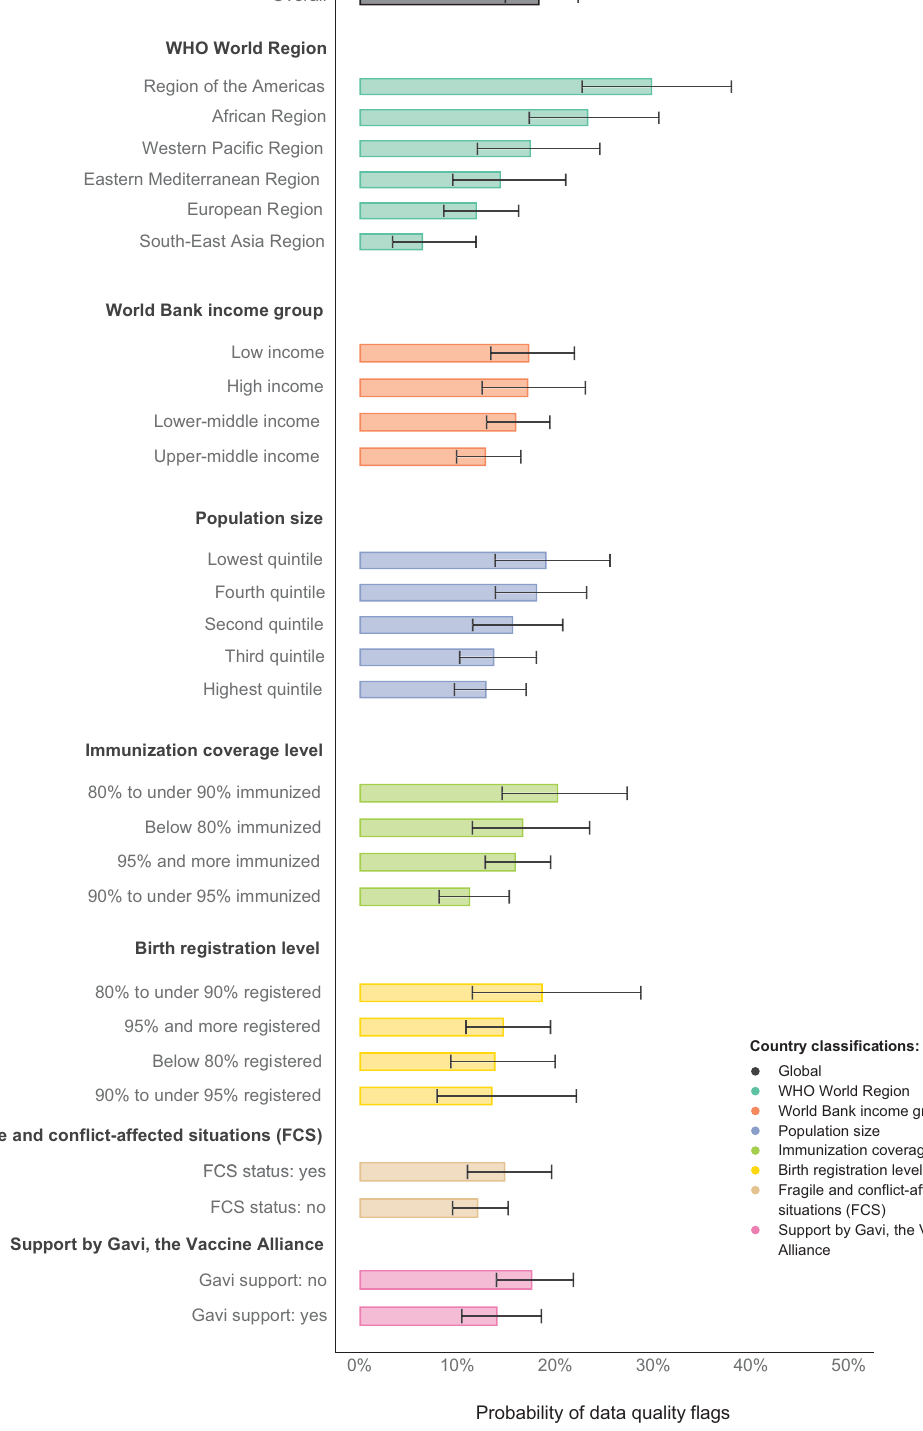
Fig 2. Modeled probability of data quality flags for immunization coverage reports for DTP1, DTP3, MCV1, and BCG worldwide and by different country classifications, 194 WHO Member States, 2000–2019. Notes: Error bars represent 95% confidence intervals (CI). Country data as reported by 15 July 2020. BCG = Bacillus Calmette-Gue´rin vaccine birth